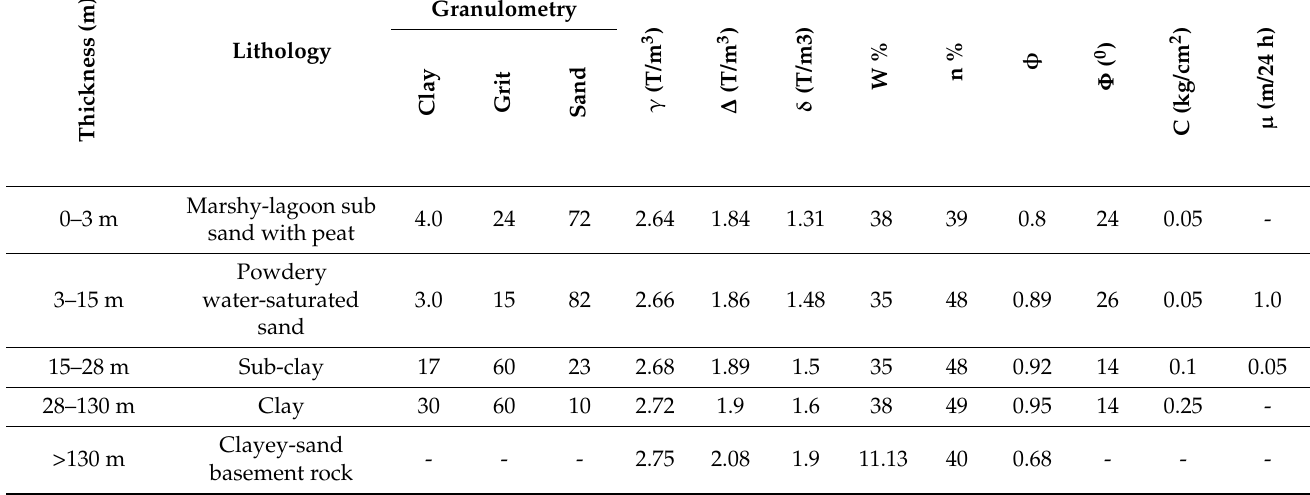
Table 2. Description of physical-mechanical parameters: γ (T/m 3 )—specific weight; ∆ (T/m 3